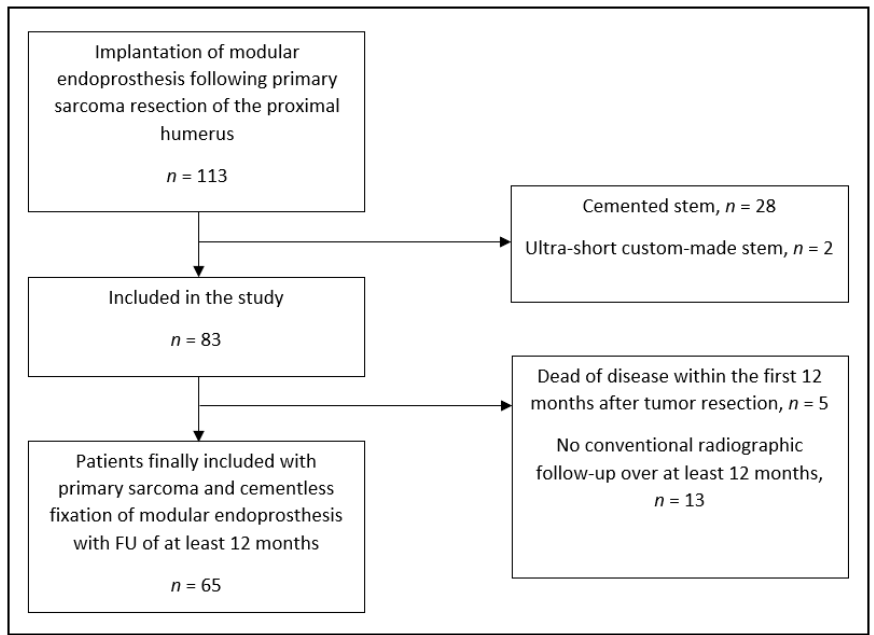
Figure 1. STROBE diagram of the study population included in this study.